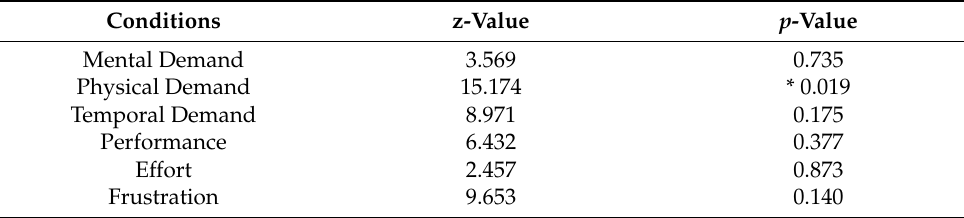
Table 4. Significant values for NASA-TLX score in overtaking vehicle session.